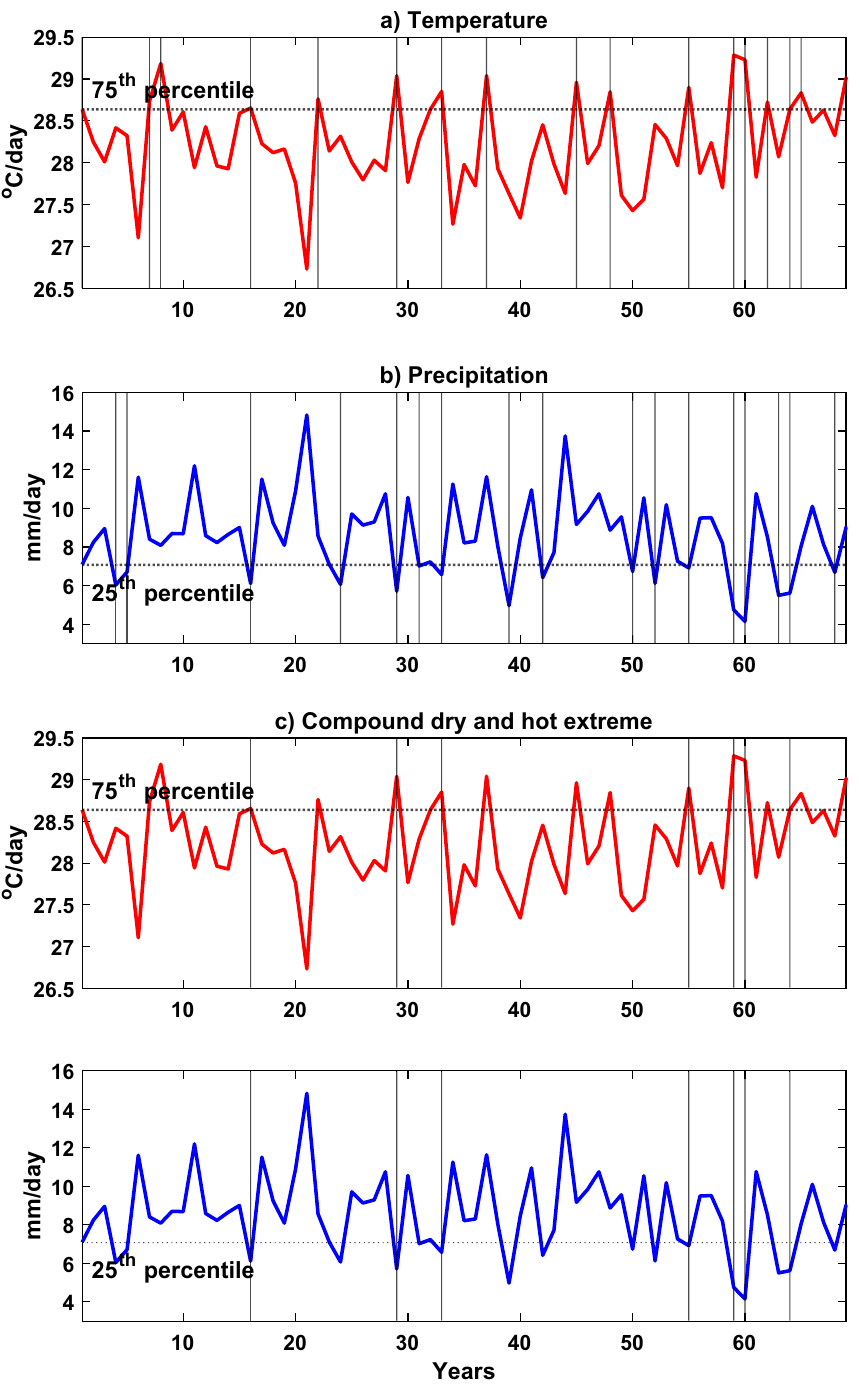
Figure 2. Illustration of a typical compound dry and hot extreme ( c ) and its comparison with univariate events ( a ) Temperature > 75th percentile and ( b ) Precipitation < 25th percentile. The vertical and horizontal lines are shown to visualize an event and the threshold used to define the